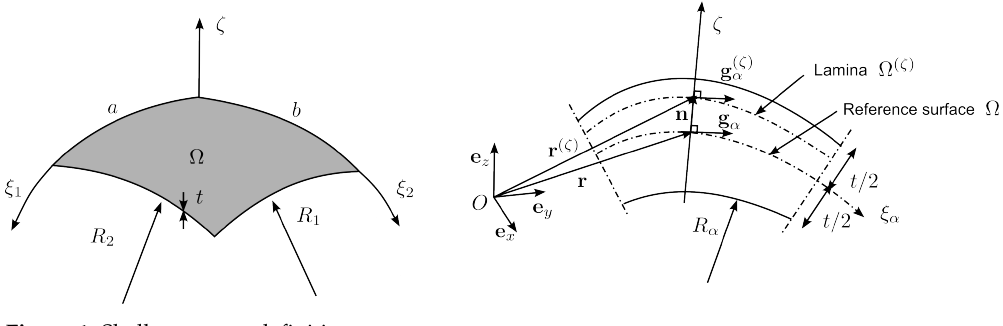
Figure 1. Shell geometry